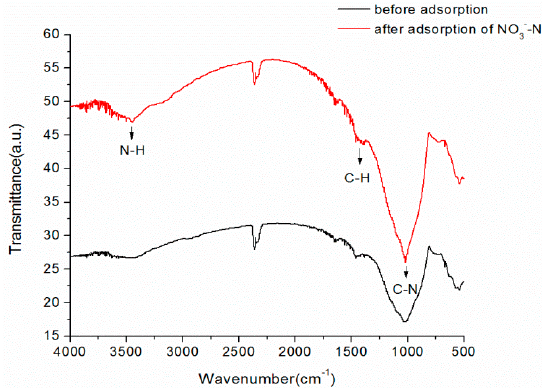
Figure 8. FT-IR spectra of scoria before and after NO 3 − -N removal.